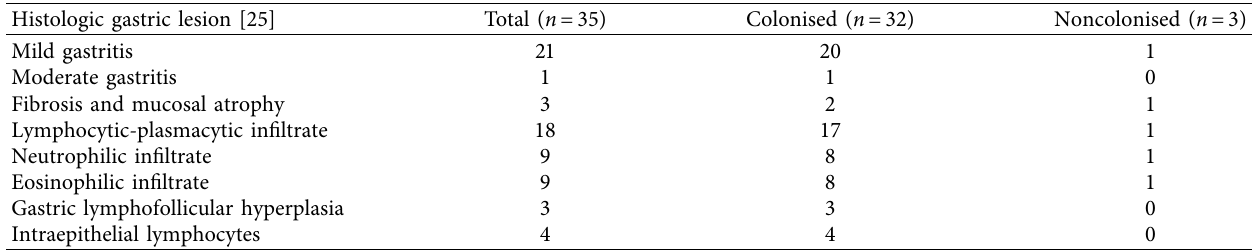
Table 2: Findings of histologic gastric lesion on dogs colonised and noncolonised with Helicobacter in the stomach (mean of scores in both gastric